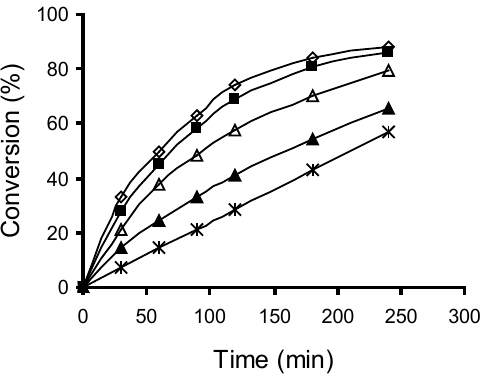
Figure 1. Effect of catalyst loading on acetic acid conversion; molar ratio acetic acid – epichlorohydrin 1:1; temperature 366 K; stirring speed 600 r.p.m.; catalyst loading (kg cat m -3 ): × 56.25; ▲ 84.375; ∆ 112.5; ■ 135; □ 168.75.